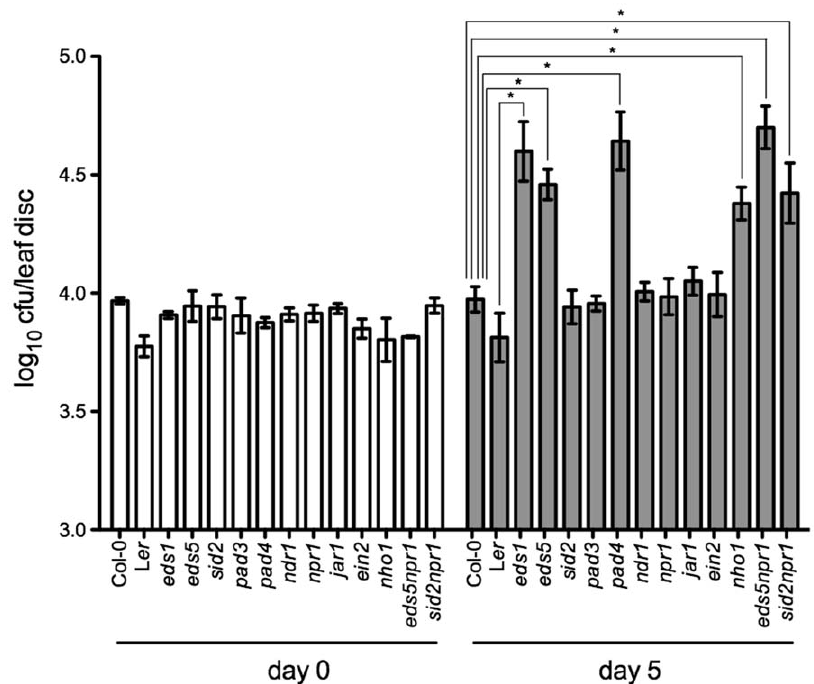
Figure 6. Growth of Xcc in several Arabidopsis SA, JA, and ET singling mutants. Leaves of four-week-old plants were inoculated with Xcc (OD 600 =0.002). The in planta bacterial titers were determined immediately (day 0) or on day 5 post-inoculation (cfu, colony-forming units). Data represent the mean of eight independent samples with standard deviation. Xcc grew significantly more in eds5 , pad4 , nho1 , eds5npr1 , and sid2npr1 than in the wild-type Col-0 plants (* P , 0.01, 0.001, 0.001, 0.001, and 0.05, respectively). Similarly, Xcc grew significantly more in eds1 than in the wild- type L er plants (* P , 0.01). The experiment was repeated three times with similar